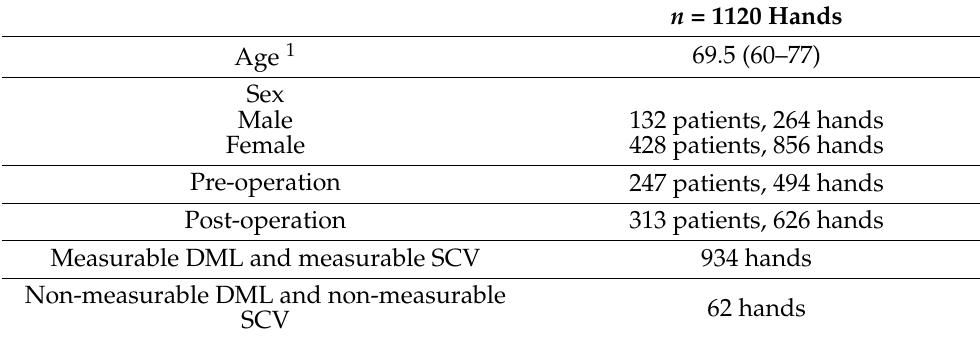
Table 1. Characteristics of the